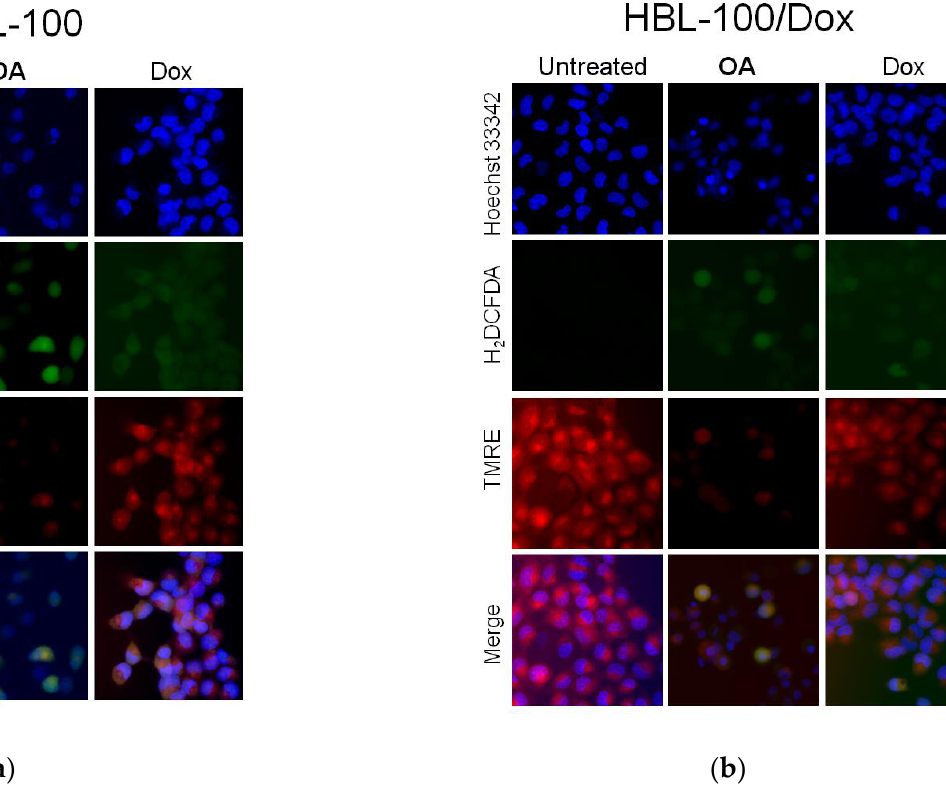
Figure 8. Merged fluorescent images of HBL-100 ( a ) and HBL-100/Dox ( b ) cells stained with Hoechst 33342 (nuclei), TMRE (mitochondria) and H 2 DCFDA (ROS formation) after treatment with OA or Dox at IC 50 for 16